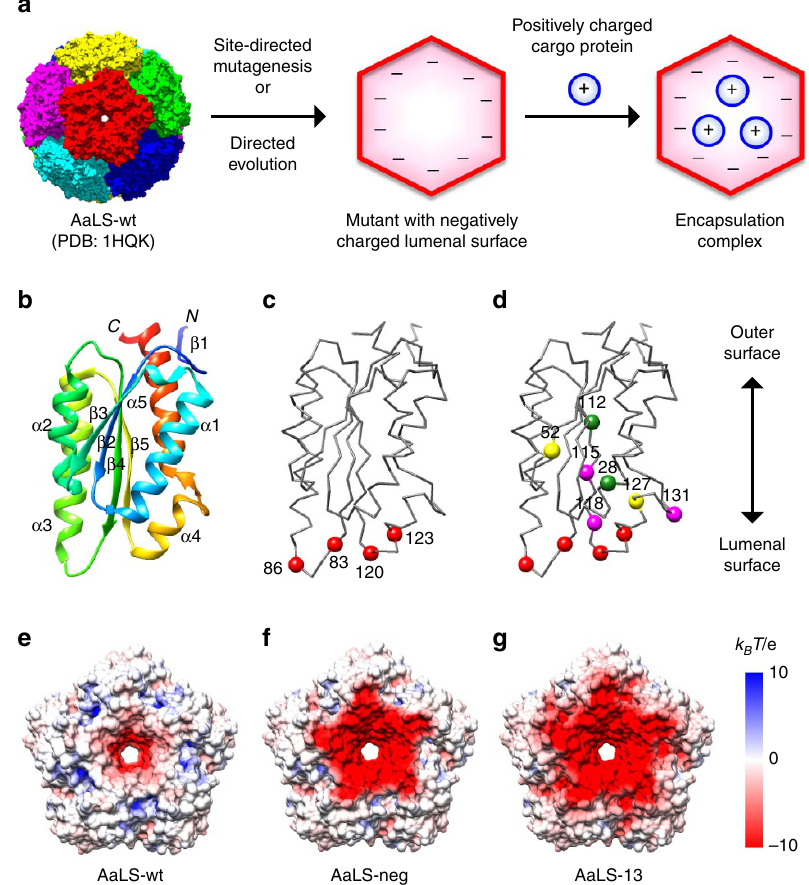
Figure 1 | Design of the AaLS encapsulation system. ( a ) Engineering AaLS cages to encapsulate cargo proteins based on electrostatic interactions. ( b ) A ribbon representation of the AaLS monomer. ( c , d ) Backbone traces of the AaLS-neg ( c ) and AaLS-13 ( d ) monomers in the same orientation as in b . Residues mutated in AaLS-neg are shown as red spheres (R83E, T86E, T120E and Q123E) ( c ), whereas the additional substitutes in AaLS-13 are shown as magenta (V115D, A118D and K131E), yellow (R52C, R127C) or green (D28G, T112S) spheres ( d ). ( e – g ) The lumenal surface of the AaLS-wt ( e ), AaLS-neg ( f ) and AaLS-13 ( g ) pentamers, showing electrostatic surface potentials assuming pH 8 and an ionic strength of 150mM. For the variants, mutations were mapped onto the crystal structure of the wt